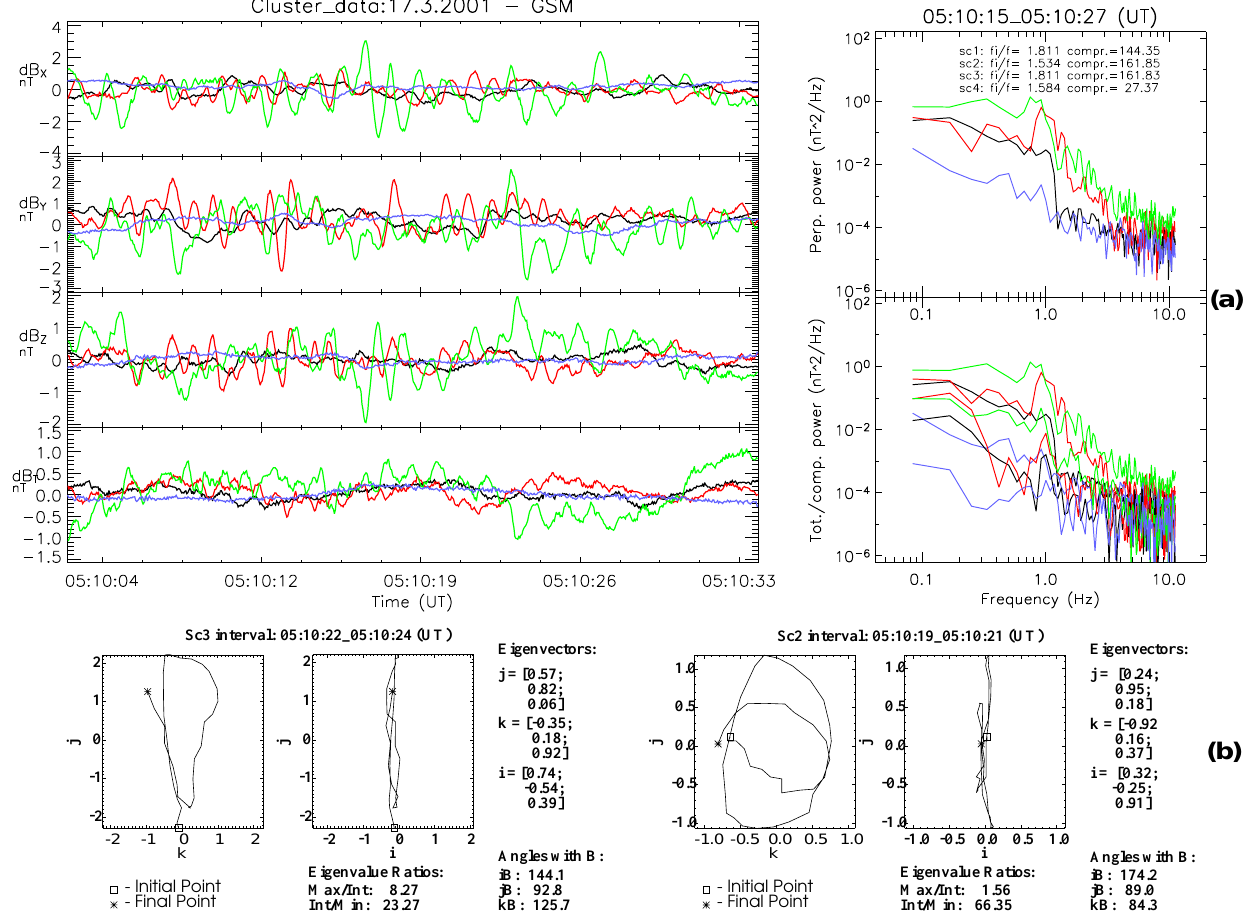
Fig. 6. (a) De-trended magnetic field components between 05:10:01 and 05:10:34 UT for all Cluster spacecraft (left). On right-hand side the upper plot shows the power in fluctuations perpendicular to the magnetic field at 05:10:15–05:10:27 UT for all 4 spacecraft. The total and parallel power are plotted on bottom, with the total power being the upper curve for each spacecraft. Panel (b) shows magnetic field hodograms for waves between 05:10:22 and 05:10:24 UT observed by SC3 (left) and between 05:10:19 and 05:10:21 UT by SC2 (right). Other information shown on the figure includes the values of R and C (in the power spectra), the minimum variance eigenvalue ratios, eigenvectors and wave propagation angles (next to the